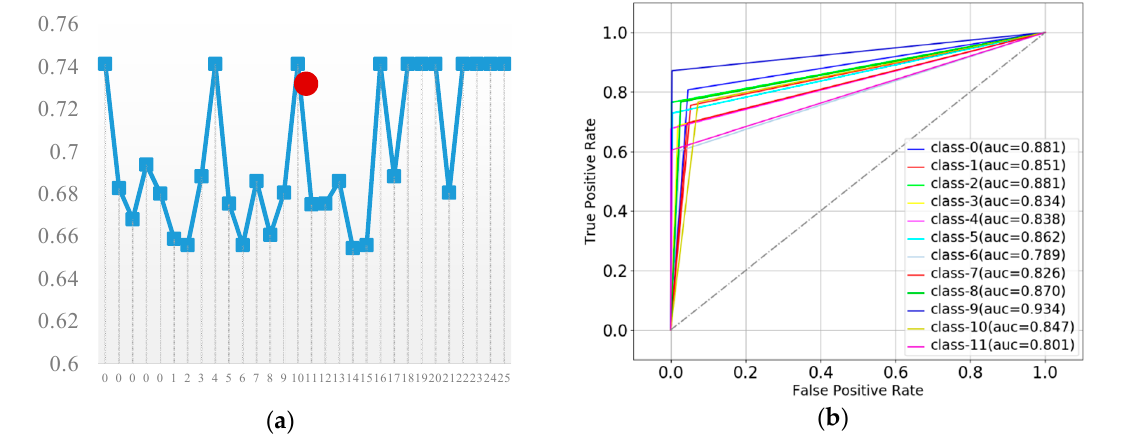
Figure 9. Parameter Tuning Process and Receiver Operating Characteristic (ROC) of K-Nearest-Neighbor (KNN), where ( a ) Description of the parameter tuning process of KNN, where y -axis is ACC and x -axis is iteration; ( b ) ROC of KNN. Table 5. Parameter Tuning Process of KNN Classifier.